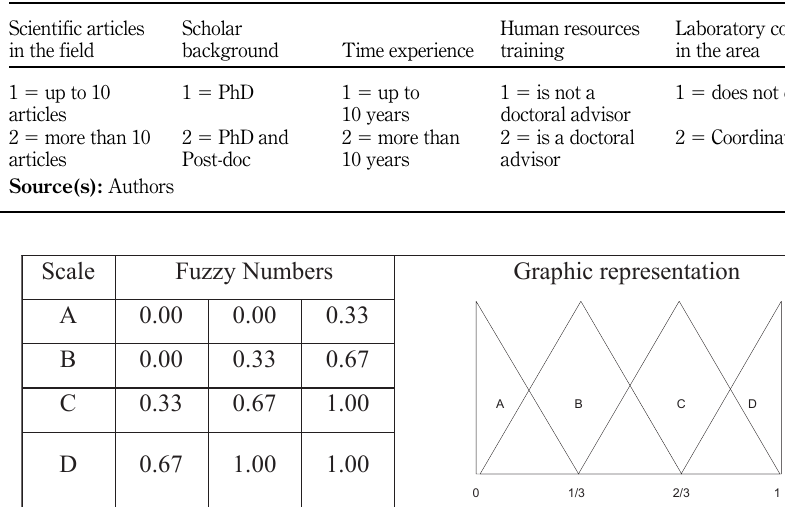
Figure 2. Fuzzification of the scaleusedinthesurvey